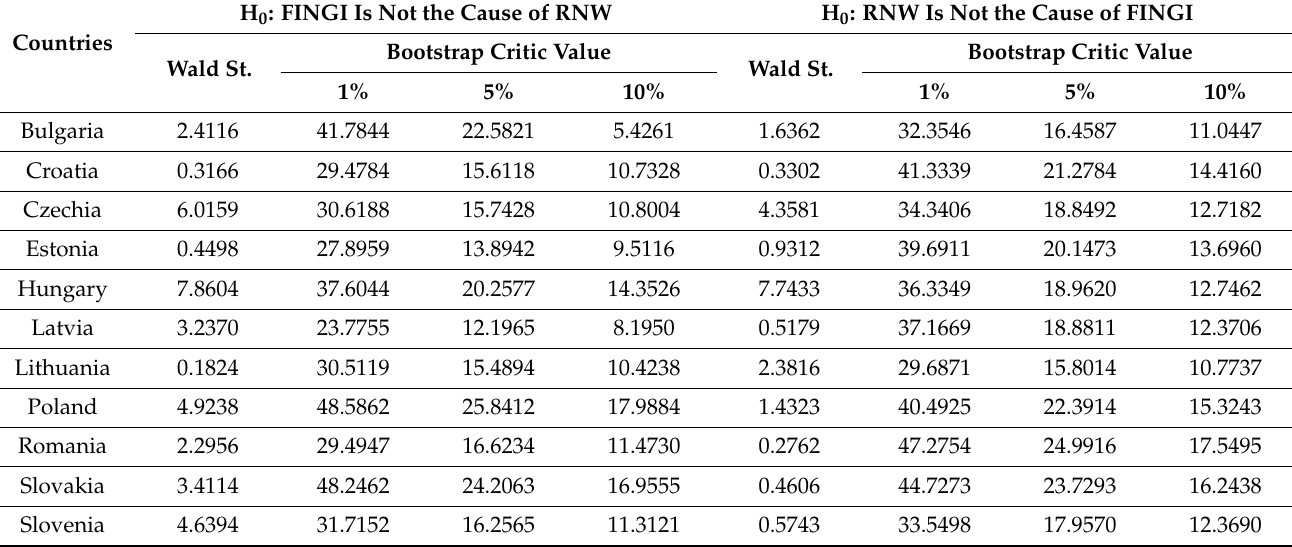
Table 7. Causality analysis between renewable energy and financial globalization.